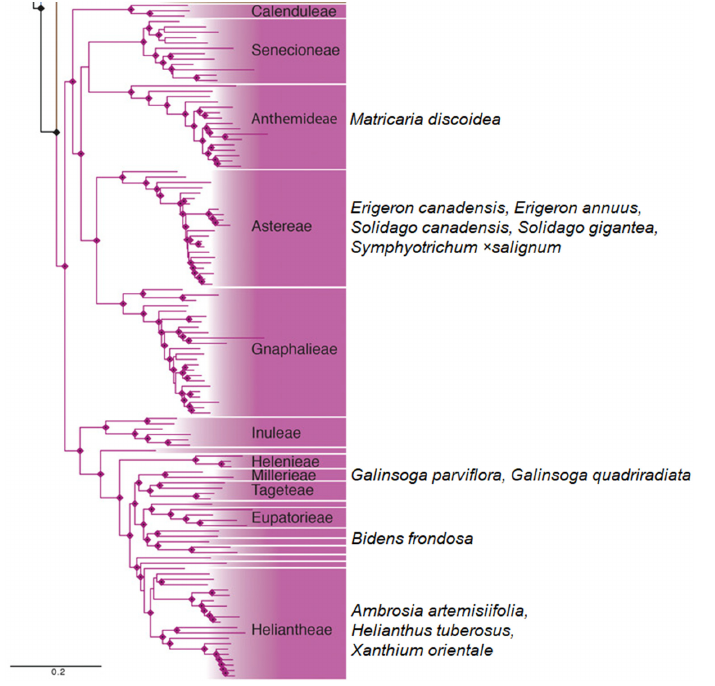
Figure 1. Phylogenetic tree of some dangerous invasive plants of subfamily Asteroideae according to Mandel et al., 2019 [77]. Depending on abiotic factors, host–plant species, and the presence of other species, the types of relationships may vary from mutualism to parasitism [46,78]. For invasive Asteraceae species, it is a powerful symbiosis. The nature of these interactions is deter- mined by the plant species and the AMF community [79]. An analysis of the occurrence